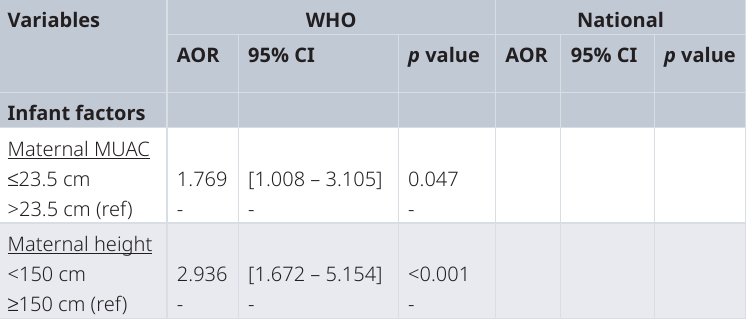
Table 4. Multivariate analysis of determinants for stunting among children aged 0–59 months in Musi